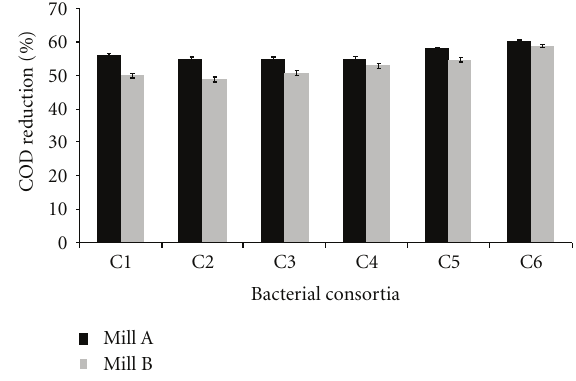
Figure 1: COD reduction of sample (back water 100%) using di ff erent consortia after 45 hrs as per control—1450 mg/L (mill A) and 1855 mg/L (mill B).